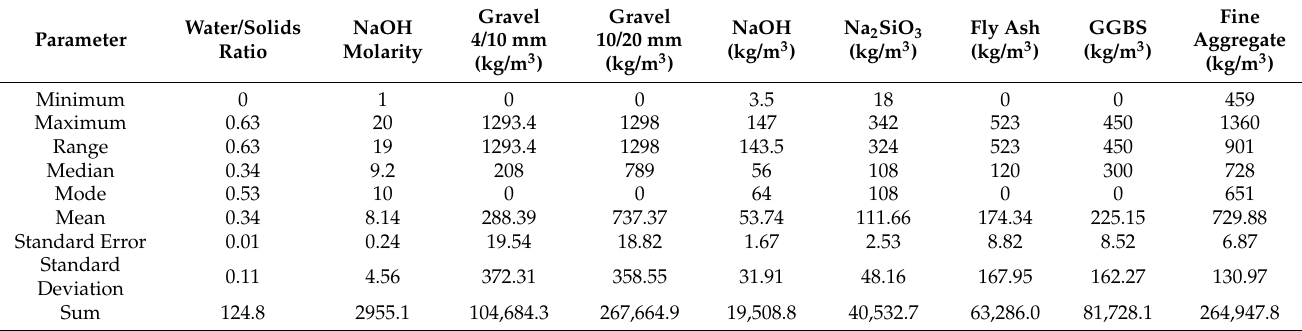
Table 1. Descriptive measurements of input variables